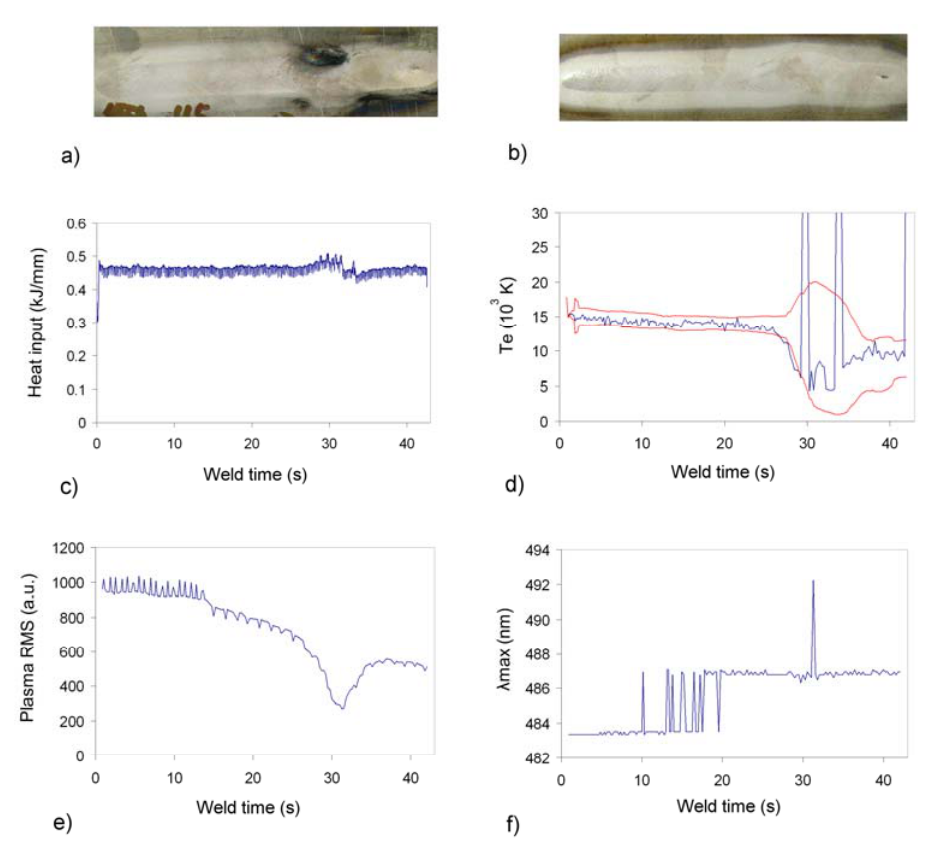
Figure 7 . Heat input, T on Titanium 6Al-4V.